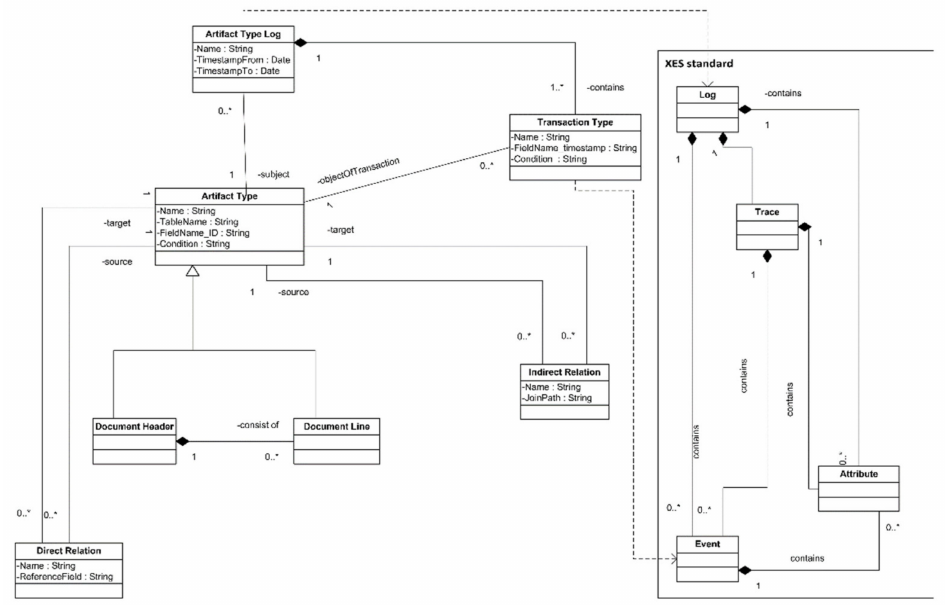
Figure 4. Abstract syntax of the DSML for supporting event log extraction from ERP